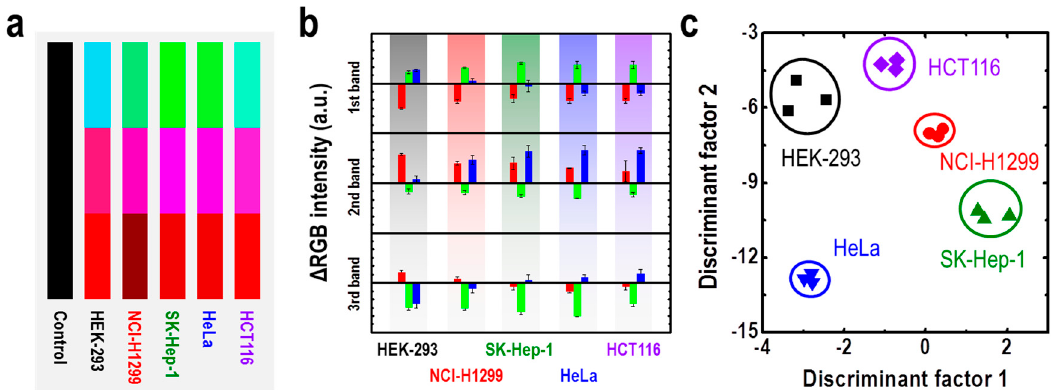
Figure 12. Cancer cell type identification using M13 bacteriophage-based color sensors. ( a ) Red, Green, and blue (RGB) color patterns of each cancer cell, ( b ) RGB intensity change, and ( c ) PCA analysis of samples. Reproduced from [72], with permission from The Royal Society of Chemistry, 2017.